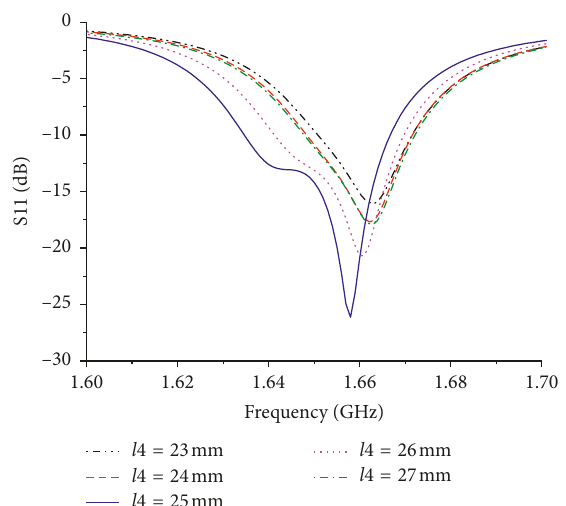
Figure 6: Antenna S11 when tuning the gap width g .